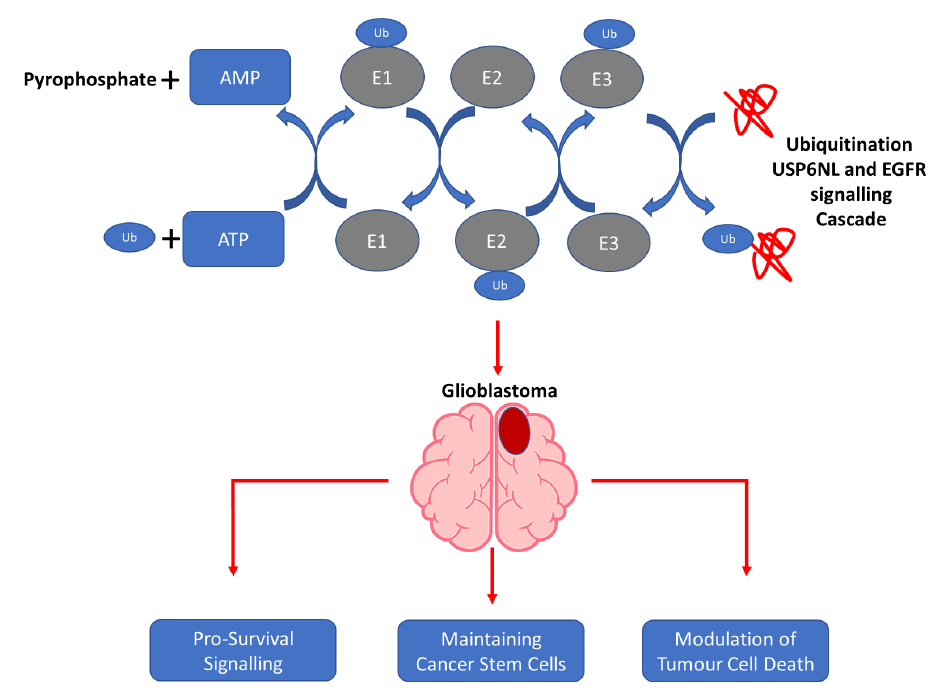
Figure 8. This study provides novel insights into the role of USP6NL/EGFR in GBM-TMZ re- sistance. The USP6NL/EGFR axis suppresses anticancer therapeutic responses, induces cancer invasiveness, and facilitates reduced sensitivity to TMZ treatment in patients with GBM in an autolysosome-dependent